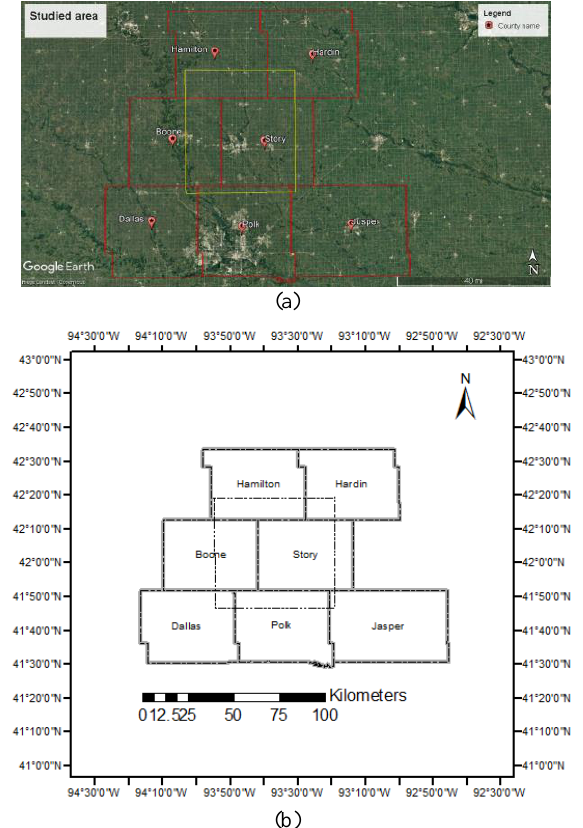
Figure 1. The google earth image (a) and the studied areas (b).